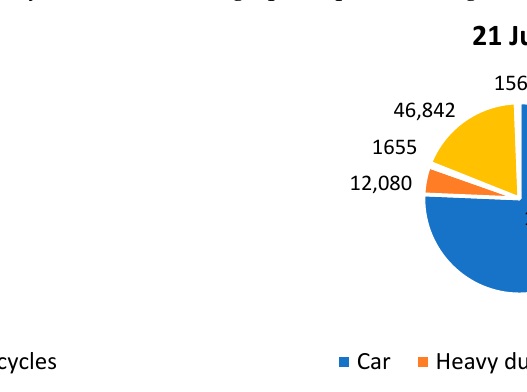
Figure 5. The vehicle feet by the two traffic monitoring campaigns grouped by vehicle category. The car category is the largest, including 79% and 76% of vehicles monitored in the first and second traffic campaign, respectively. The motorcycles category counts for about 16% of vehicles by the first monitoring day and 18% by the second monitoring day. for vehicles, and 1% for bus.